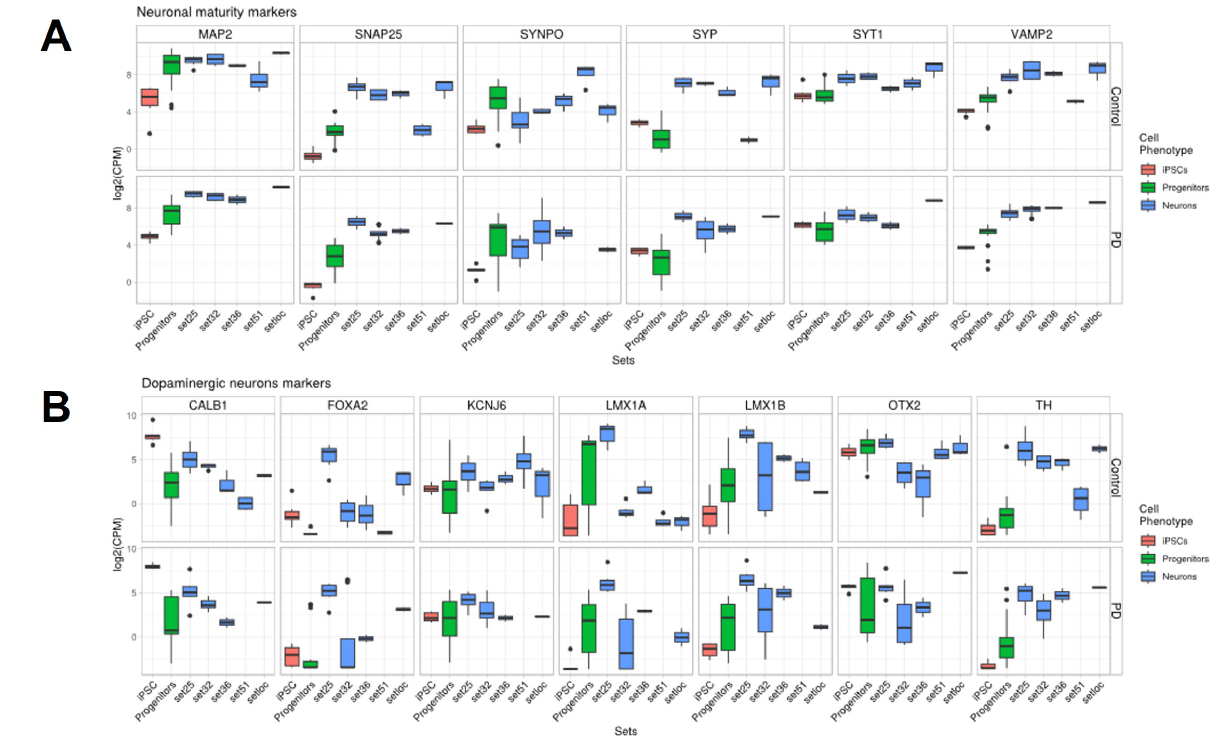
Figure 9. Expression levels of markers of mature neurons, midbrain DAn as well as A9 and A10 subtypes of DAn in comparison between datasets. ( A )—neuronal maturity markers; presents the genes responsible for the functioning of synaptic transmission ( SYP , SYNPO , SNAP25 , VAMP2 , SYT1 ) and the cytoskeleton ( MAP2 ). ( B )—midbrain DAn markers ( TH , FOXA2 , LMX1A , LMX1B , OTX2 ),